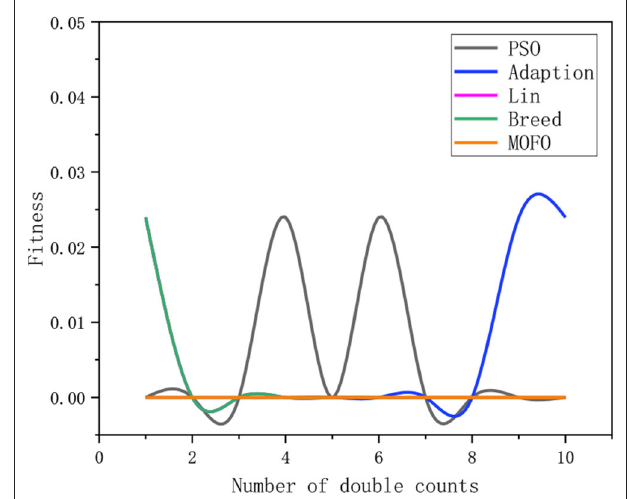
FIGURE 10 | The relation between the fitness value and the number of iterations of the MOFOPSO algorithm.